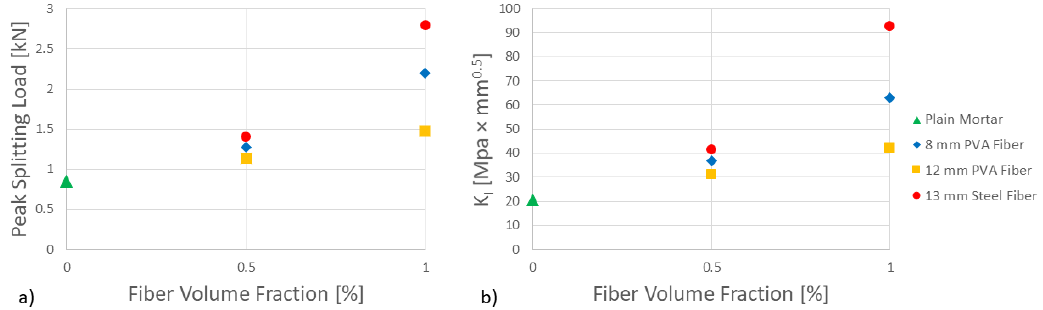
Figure 6. ( a ) Peak splitting loads (SL) and ( b ) and critical stress intensity factors (K I ) obtained for various fiber types and volume fractions .